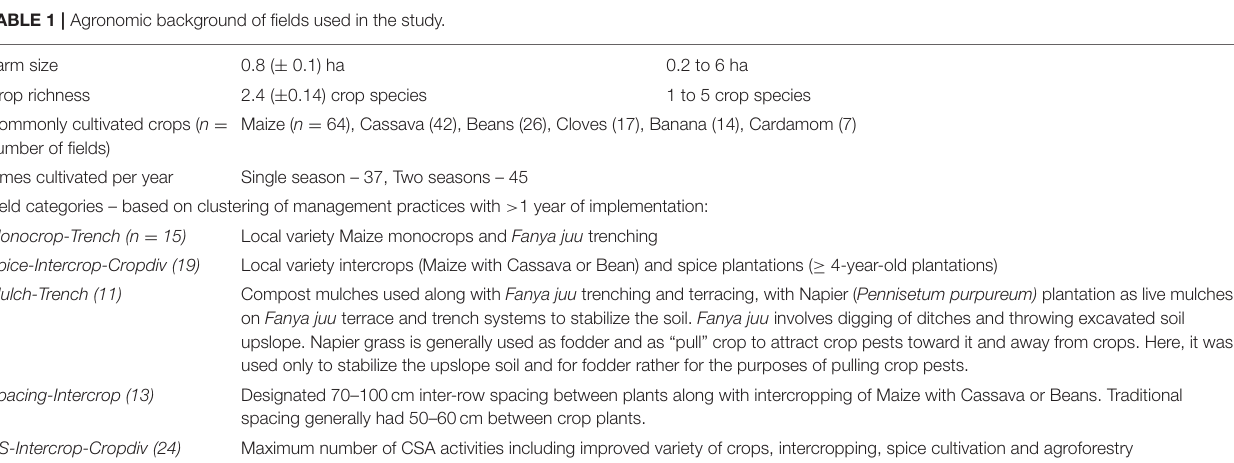
TABLE 1 | Agronomic background of fields used in the